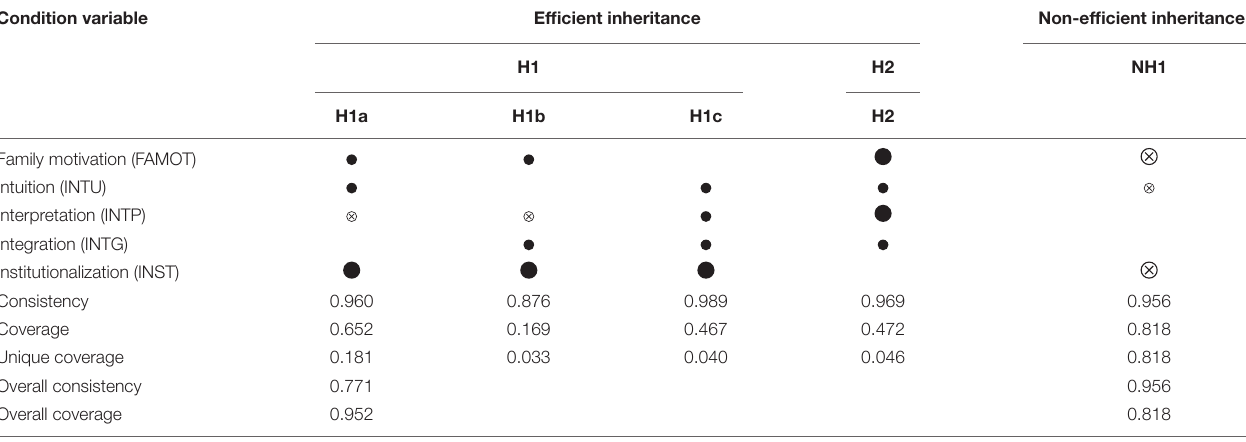
TABLE 3 | Configuration model of inheritance of the craftsmanship spirit. Condition variable Efficient inheritance Non-efficient